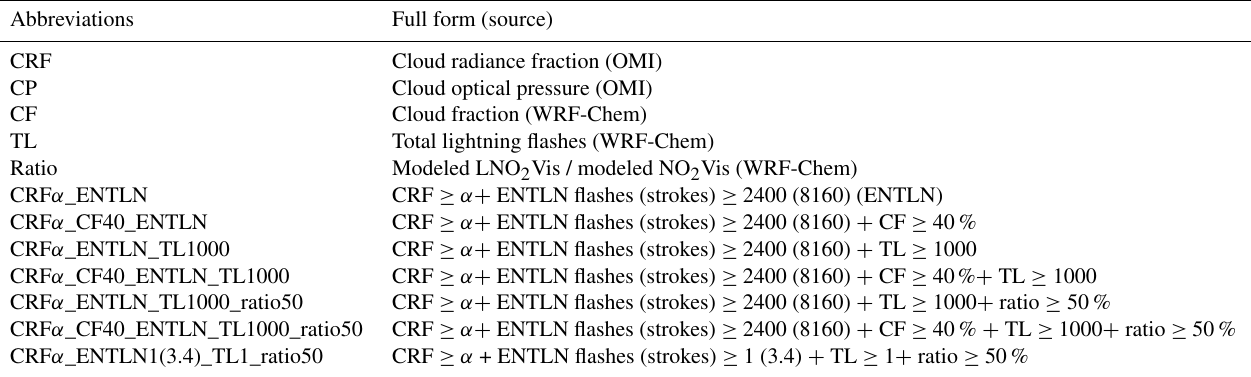
Table 1. Definitions of the abbreviations for the criteria used in this study.